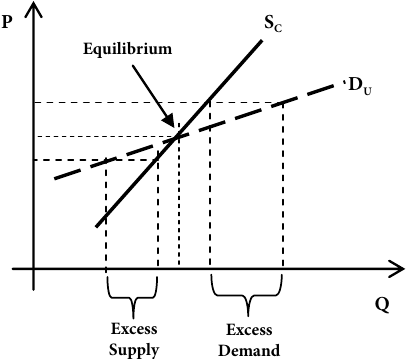
Fig. 1. Graphical representation of upward demand and classical Table 3. Effect on the price and quantity of equilibrium of shifts in the Giffen demand and classical supply curves (when the demand is more / less elastic than the supply) SHIFTS S constant S increase S decrease C C C constant P & Q constant P & Q ↑ / ↓ P & Q ↓ / ↑ D G increase P & Q ↓ / ↑ P & Q ? P & Q ↓ / ↑ D G decrease P & Q ↑ / ↓ P & Q ↑ / ↓ P & Q ? D G